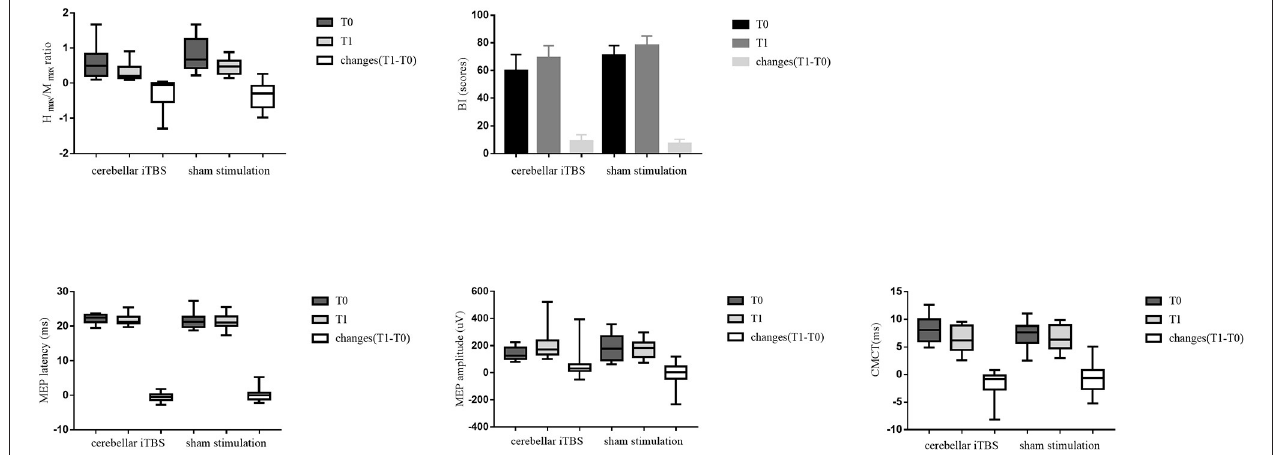
FIGURE 3 | The statistical analysis results between groups for the secondary outcomes. The data are expressed as the Median with IQR or Mean with